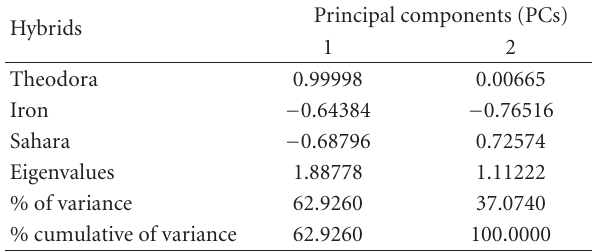
Table 3: Correlation of each hybrid with the two principal compo- nents.